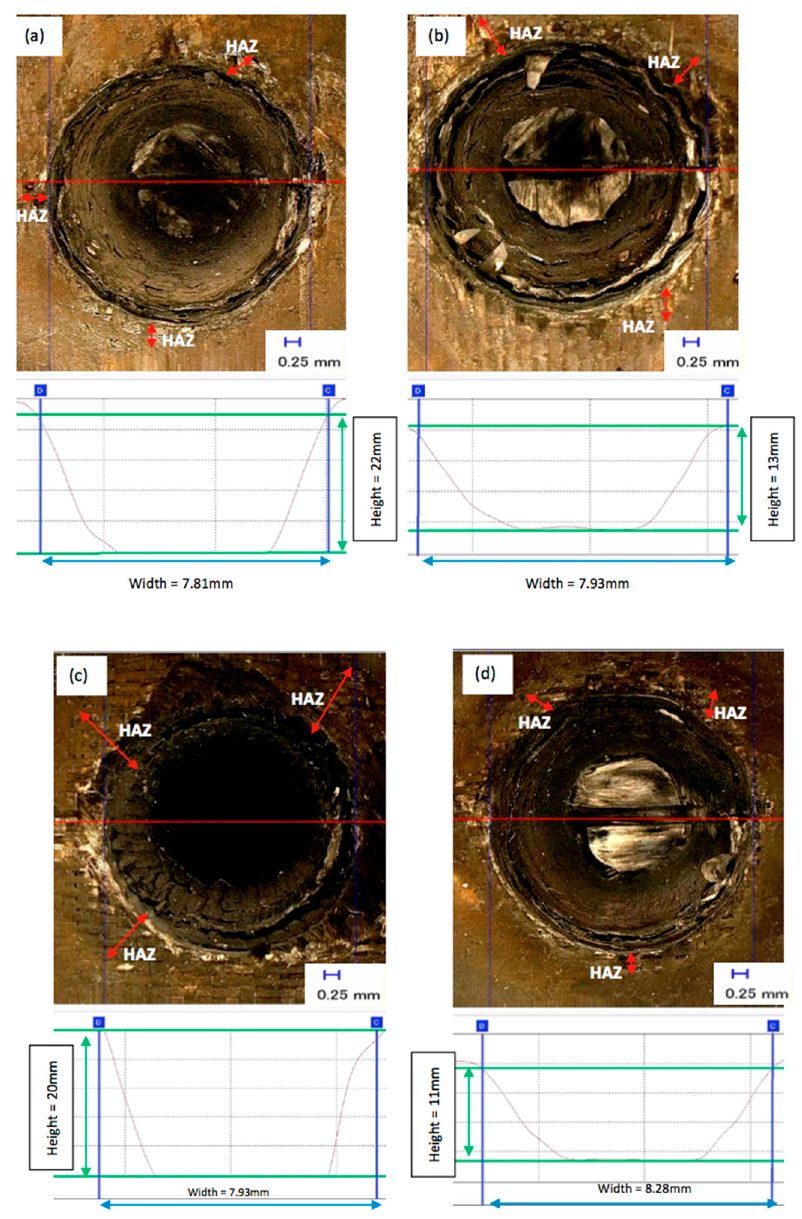
Figure 9. Top view and profile of hole cut at different laser powers/scanning speeds: ( a ) 900 W and ( b ) 400 W at a constant speed of 10 mm/s, and ( c ) with constant laser power of 900 W at 20 mm/s and ( d ) 50 mm/s.